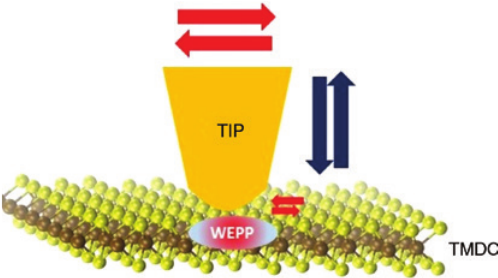
Figure 9: Mobile and pliable WEPP in two-dimensional materials (such as transition metal